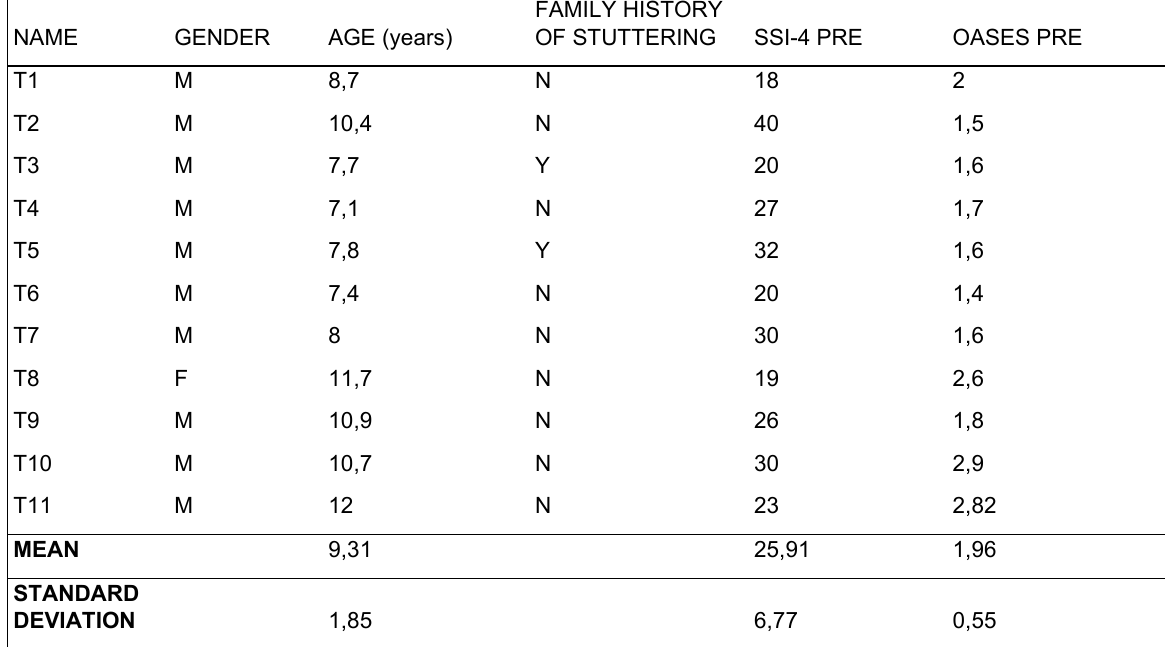
Baseline Characteristics of Patients in Telepractice